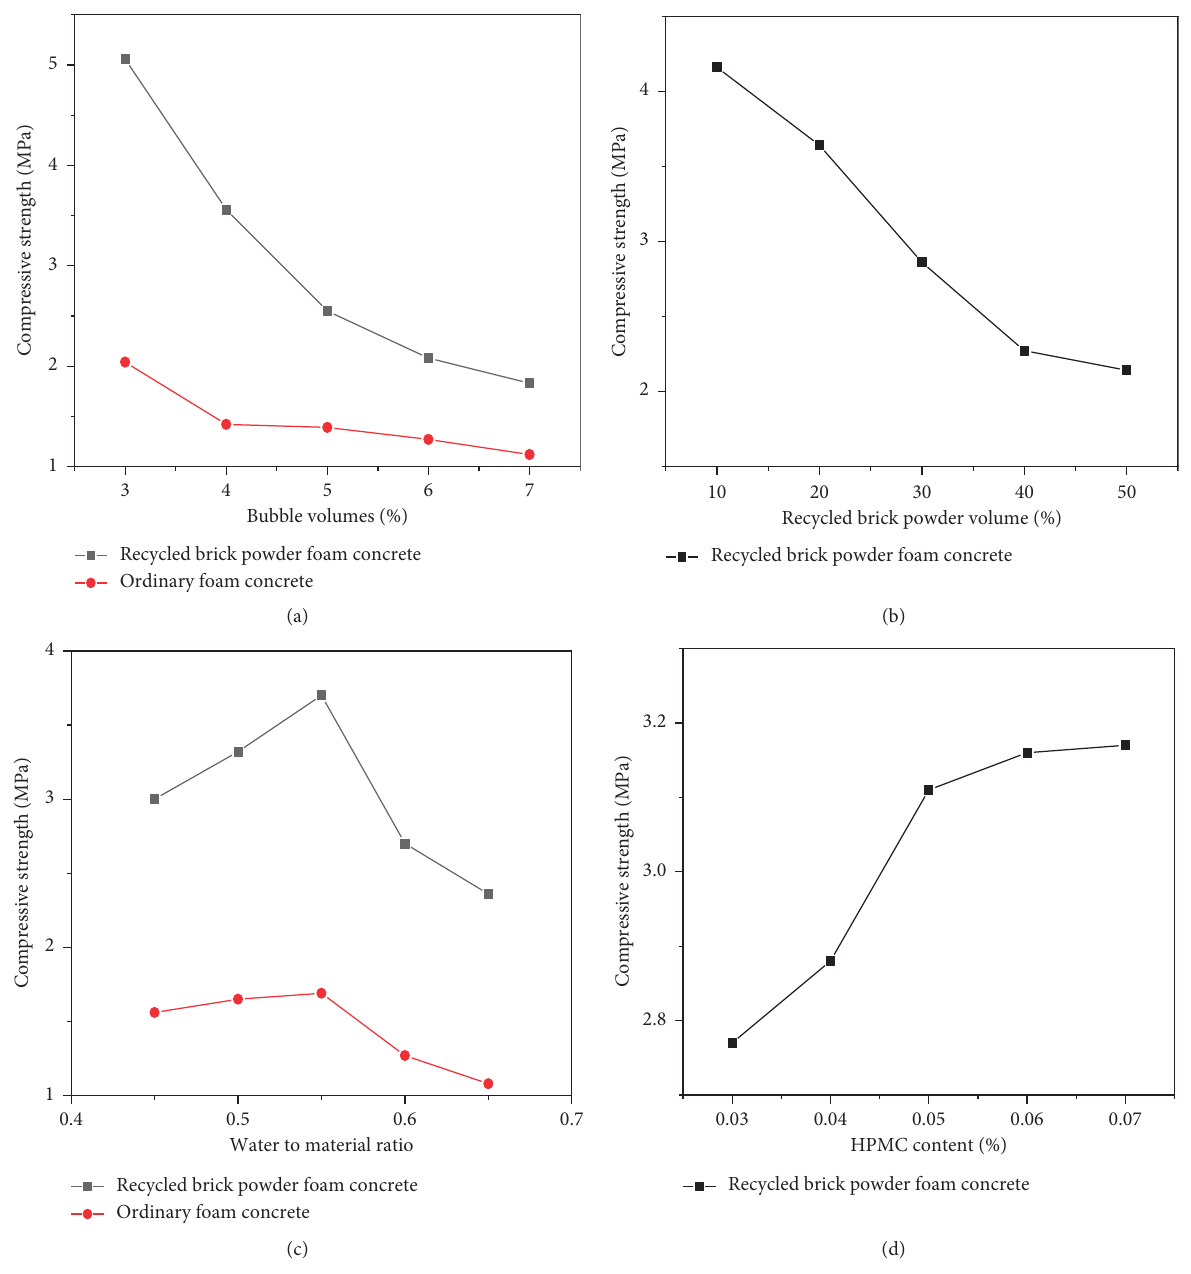
Figure 6: Changes in the influence of various factors on compressive